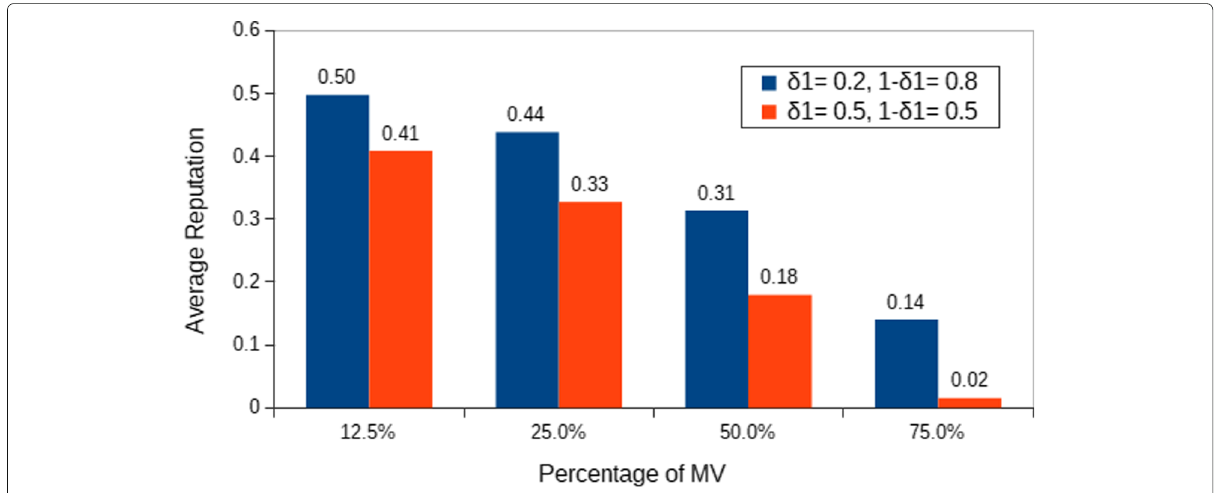
Fig. 11 Average reputation of the vehicles varying δ